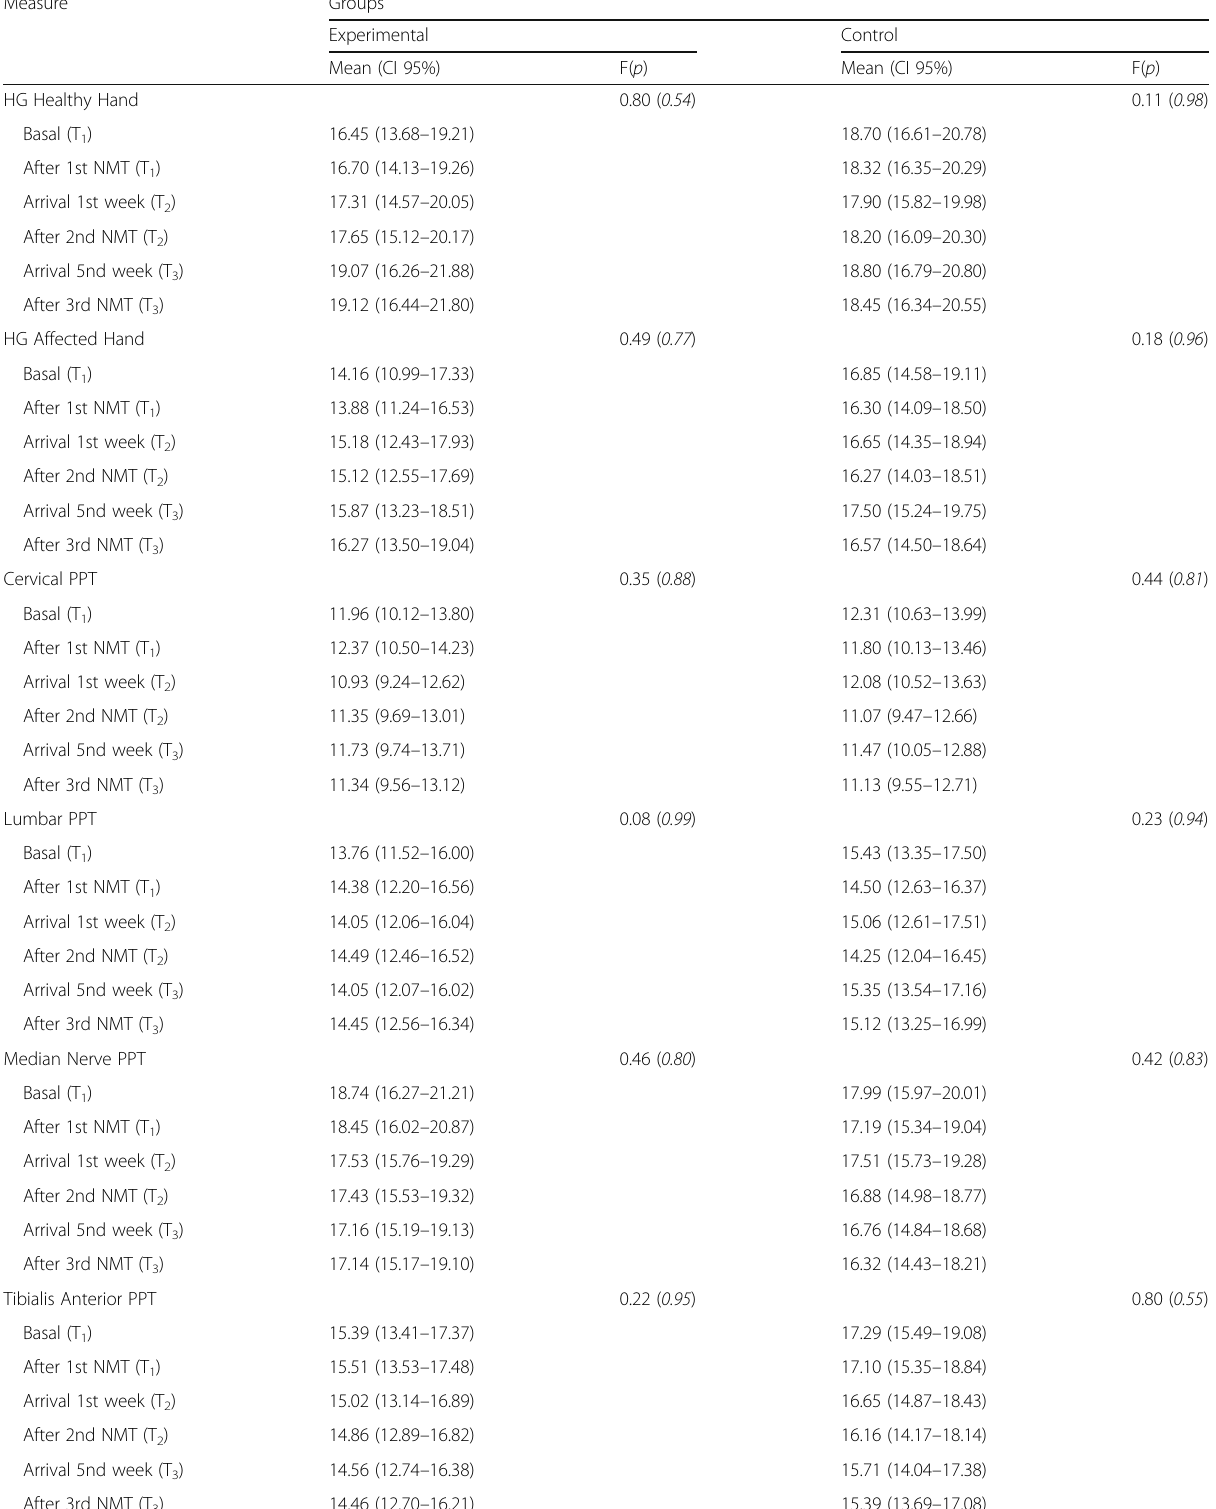
Table 5 Change in grip strength (kg) and pressure pain threshold from baseline to 5 week neuromuscular taping